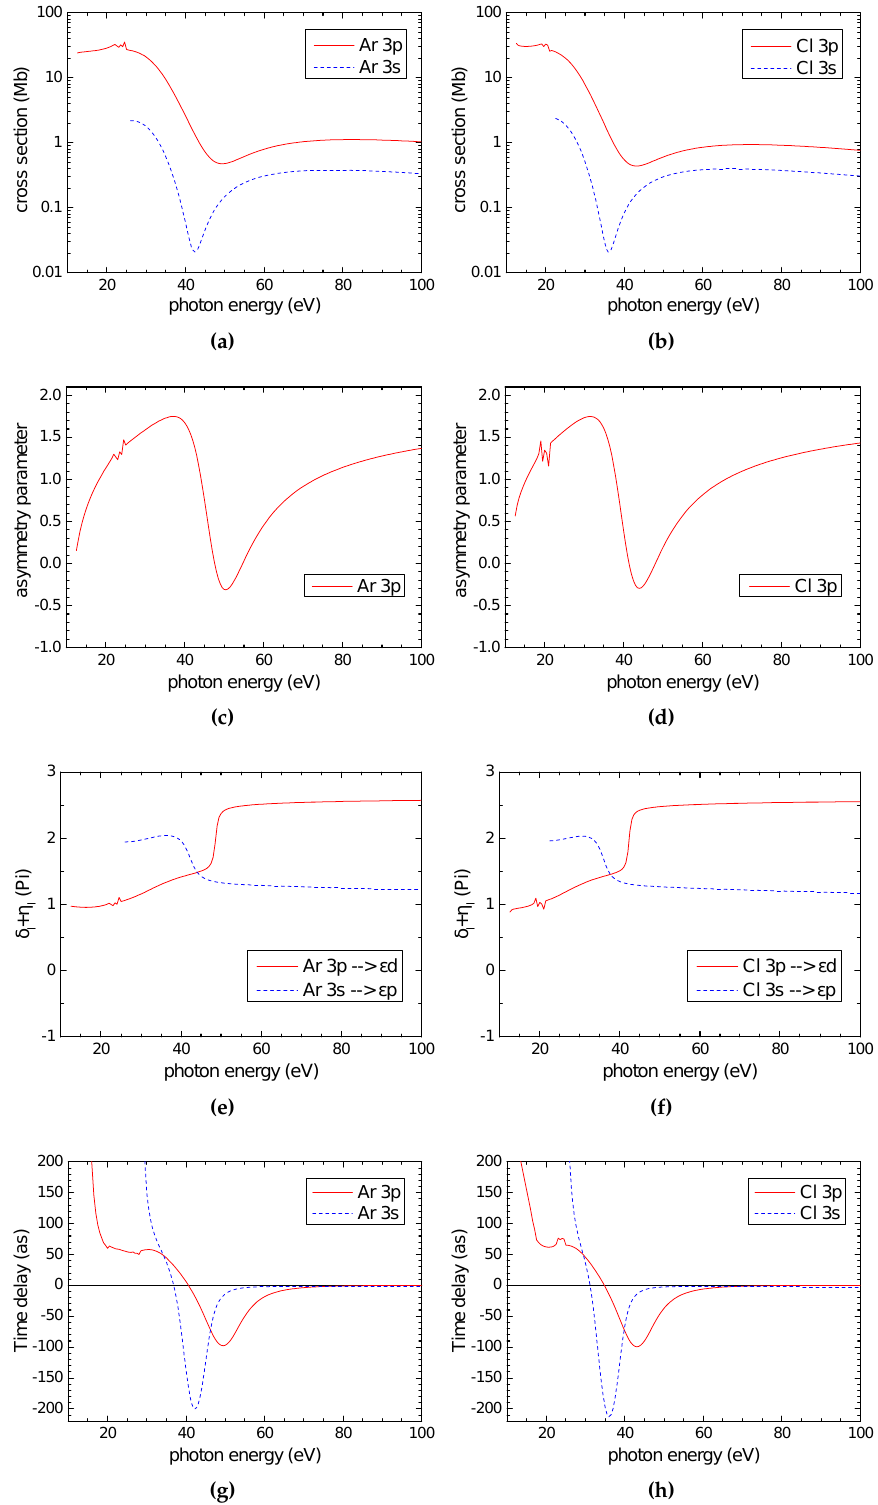
Figure 3. Left to right columns: calculations for argon ( a , c , e , g ) and chlorine ( b , d , f , h ) atoms. Top to bottom rows: partial cross section ( a , b ); asymmetry parameter ( c , d ); short-range plus induced phase shift ( e , f ); and Wigner time delay ( g , h ) for subshells 3 p and 3 s